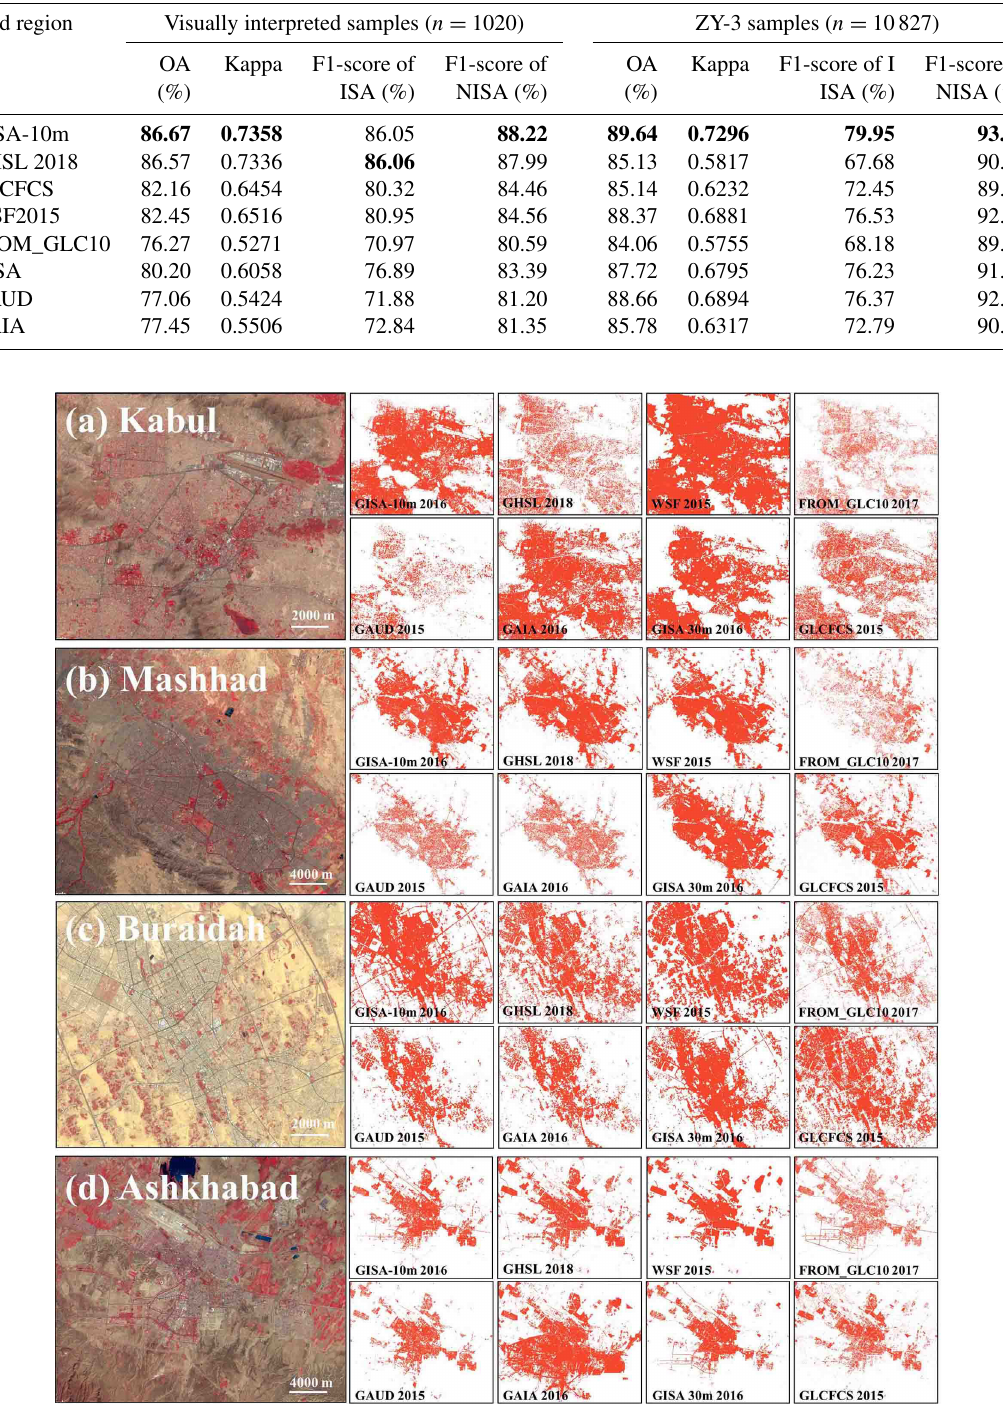
Table 5. Results of quantitative accuracy assessment via visually interpreted and ZY-3 samples in arid regions between GISA-10m and the existing ISA datasets. OA represents the overall accuracy. Bold numbers represent the highest value for each metric.